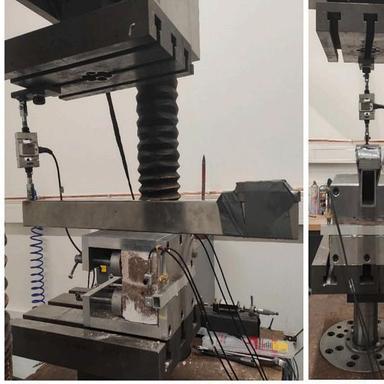
Test set-ups: (a) compressive tests on cores and prisms; (b) splitting tests on cores; (c) shear-compression tests on triplets; (d) bond wrench tests on couplets.